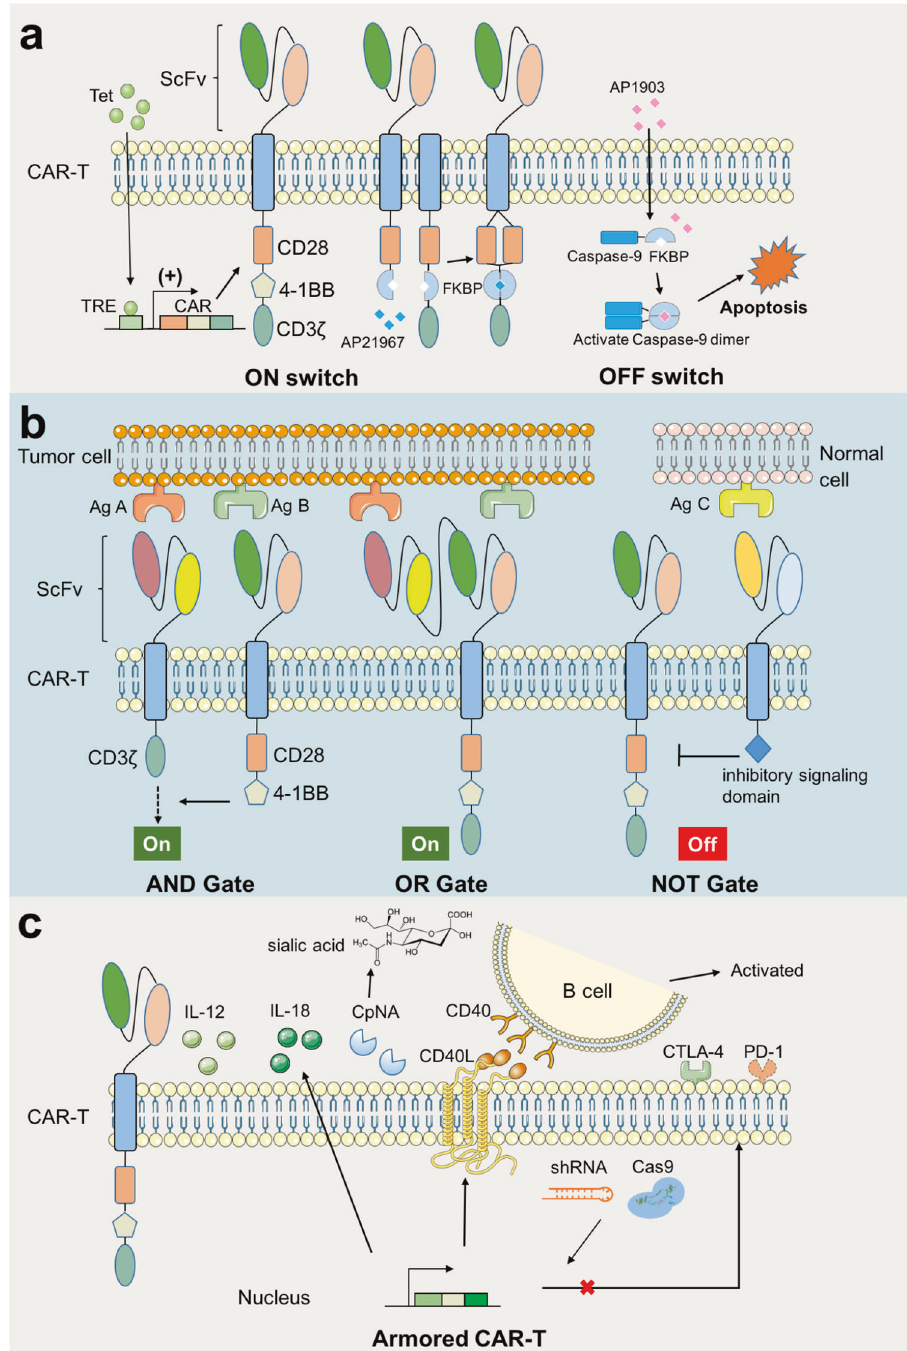
Fig. 4 Synthetic Biology in CAR-T Cell Engineering for cancer therapy. Current strategies can be divided into three types: a Switchable CAR, b Logic gates, and c Armored CAR. a Switchable CAR includes ON switches and OFF switches. In ON switches, exogenous molecules could activate the expression of CAR elements or the recombination for activate state. In OFF switches, the exogenous molecules induce the suicide genes such as iCasp9 for controlled elimination. Tet tetracycline, TRE tetracycline response element, FKBP a rapamycin-binding protein, AP21967 rapamycin analog, AP1903 dimer inducers. b Logic gates includes AND Gate, NOT Gate, and OR Gate. The activation of CAR depends on the number and type of antigens from tumor cells. Ag antigen. c As for Armored CAR-T, CAR-T cells are engineered to expression extracellular proteins including IL-12, IL-18, other enzymes or transmembrane ligands or receptors to enhance immune response. Intracellularly engineered CAR-T cell is another powerful strategy, such as inhibiting the transcription of immune-checkpoint molecules by shRNA or CRISPR-Cas9. IL-12 Interleukin 12, CpNA C. perfringens neuraminidase, CD40 cluster of differentiation 40, CD40L CD40 ligand, shRNA short-hairpin RNAs, CTLA-4 cytotoxic T-lymphocyte-associated antigen-4, PD-1 programmed